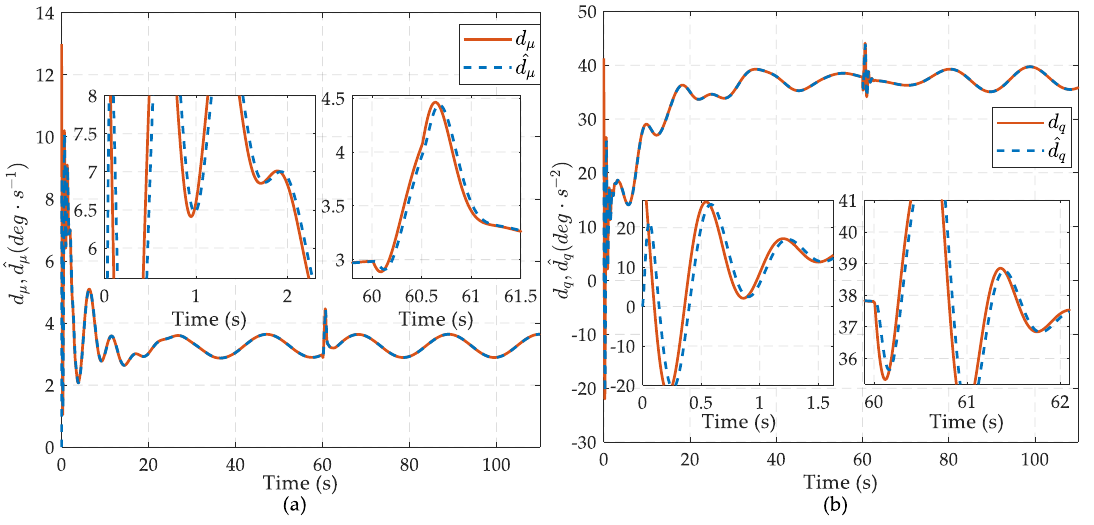
Figure 9. The output of the extended state observers (ESOs): ( a ) The compound disturbances and its estimation in the flight path angle loop and ( b ) the compound disturbances and its estimation in the pitch angular rate loop.